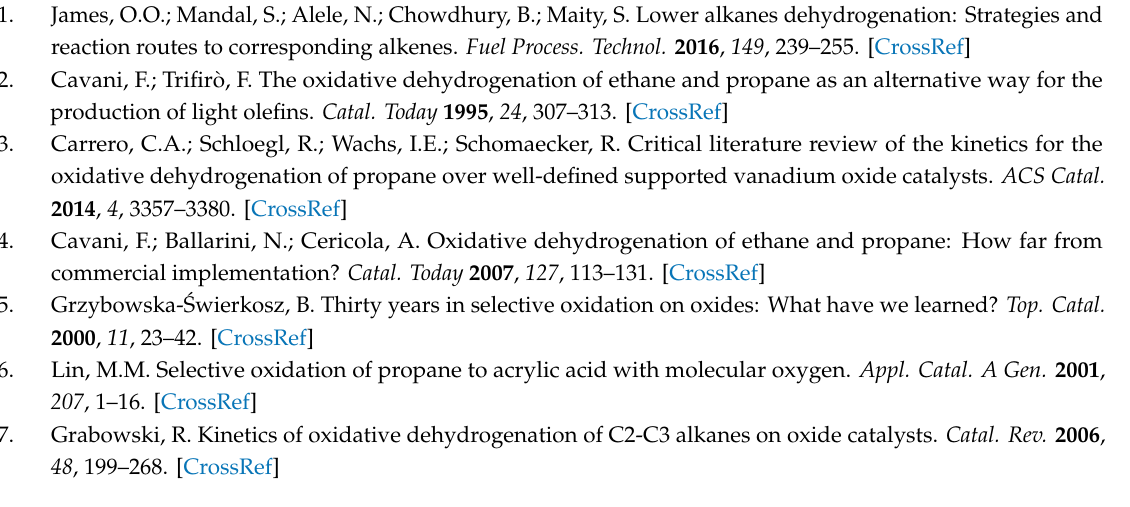
Table S2: Results of the catalytic tests for the V 1.0 FAU sample. Table S3: Results of the catalytic tests for the V 3.0 FAU sample. Table S4: Results of the catalytic tests for the V 6.0 FAU sample. Table S5: Results of the catalytic tests for the V 1.0 FAUdes sample. Table S6: Results of the catalytic tests for the V 3.0 FAUdes sample. Table S7: Results of the catalytic tests for the V 6.0 FAUdes sample. Table S8: Comparison of the initial catalytic